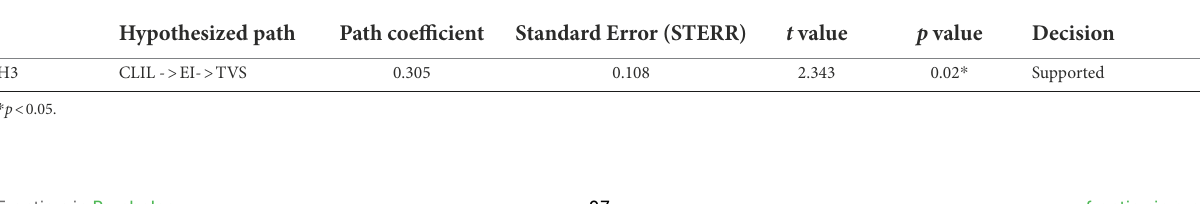
TABLE 5 Results of mediating